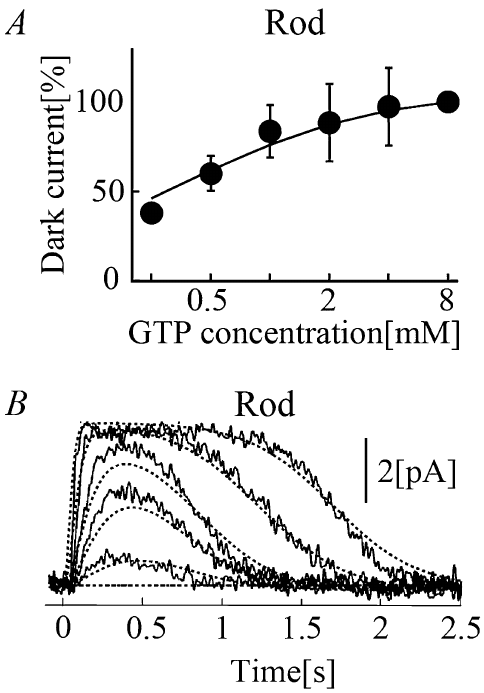
Figure 5. I CNG in rods and cones. ( A ) [GTP] i -dependent I CNG recorded from a truncated outer segment of frog rods (circle), normalized to I CNG at 8 mM [GTP] i 14 . Corresponding simulation results at steady-state were superimposed onto the experimental data (solid line). ( B ) Time courses of light-induced I CNG as a function of flash intensity recorded from the outer segments of the carp rods (light stimuli; 5.1E−6, 1.6E−5, 5.1E−5, 1.6E−4, and 5.1E−4%) 14 . Simulated I CNG for rods reproduced under the corresponding experimental conditions was superimposed onto the experimental results (dotted